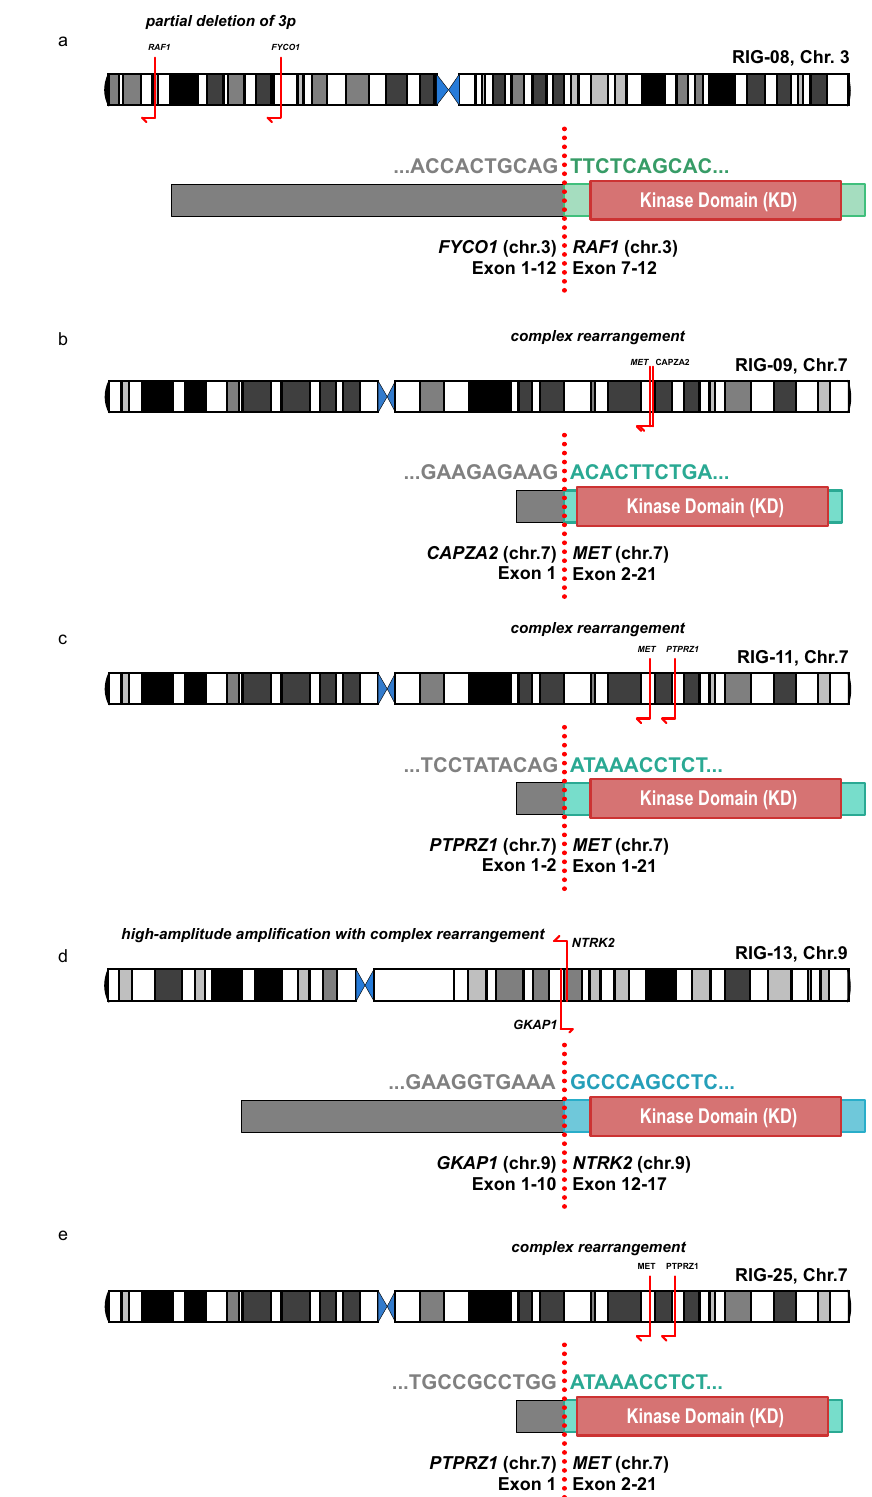
Fig. 6 Alternative genetic rearrangements leading to aberrant MAPK/ERK pathway signaling. Partial deletions of chromosomal arm 3p induce formation of a FYCO1:RAF1 fusion ( a ), with occurrence of a GKAP1:NTRK2 fusion ( d ) emerging through inversion of a chromosomal arm 9q segment. Both rearrangements are predicted to lead to constitutive activation of the kinase domain (KD). Induced by complex rearrangements, CAPZA2:MET ( b ) and PTPRZ1:MET fusion ( c , e ) contained almost the full length MET protein, with overexpression driven by the highly active CAPZA2 or PTPRZ1